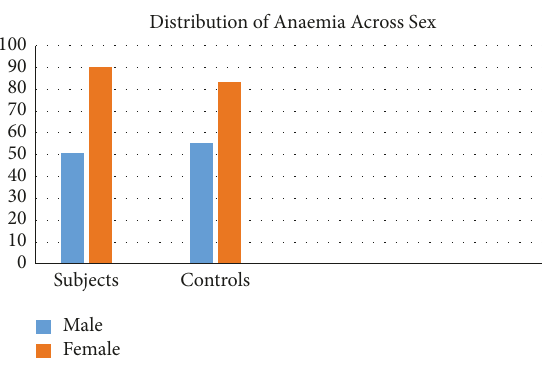
Figure 1: Distribution of anaemia across sex. Table 7: The pattern of anaemia among the anaemic subjects (83).